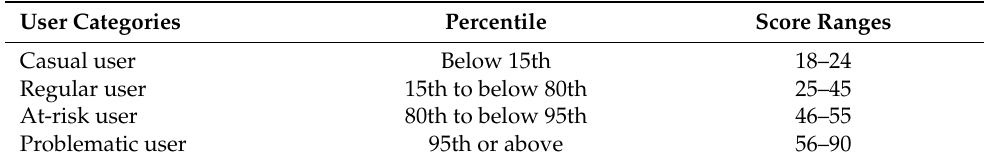
Table 3. User categories and scores ranges.